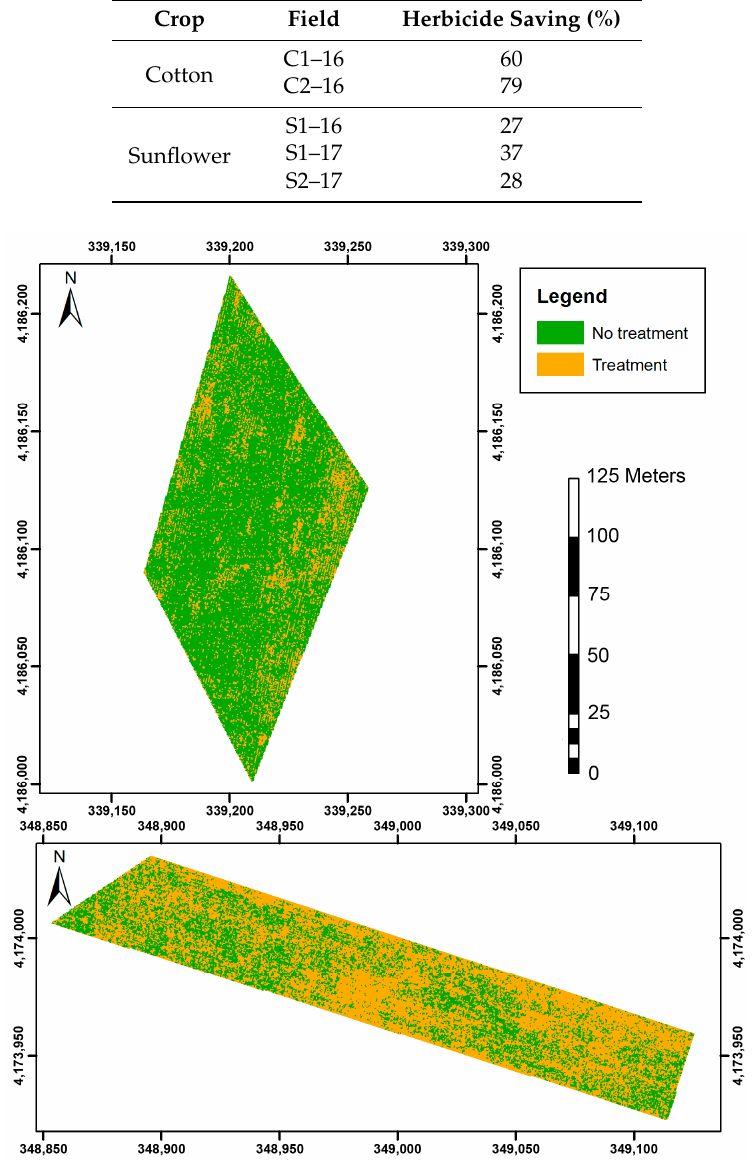
Figure 11. Prescription maps based on a treatment threshold of 0% obtained in: ( a ) sunflower; ( b ) cotton. Reference system UTM 30N, datum ETRS-89.